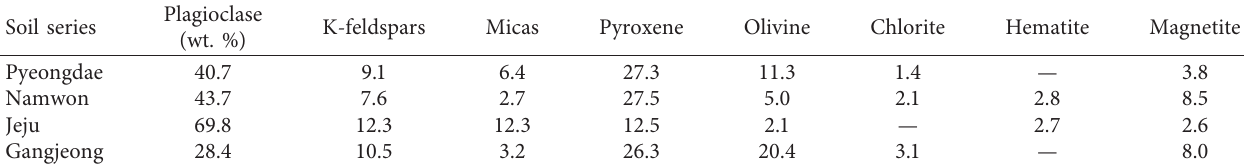
Figure 1: The variation of mass transfer coefficients for Nb and Zr element from four soil profiles ( ■ , Pyeongdae; ● , Namwon; □ , Jeju; ○ , Gangjeong) using Zr and Nb as immobile elements. Table 3: Mineral compositions of basaltic